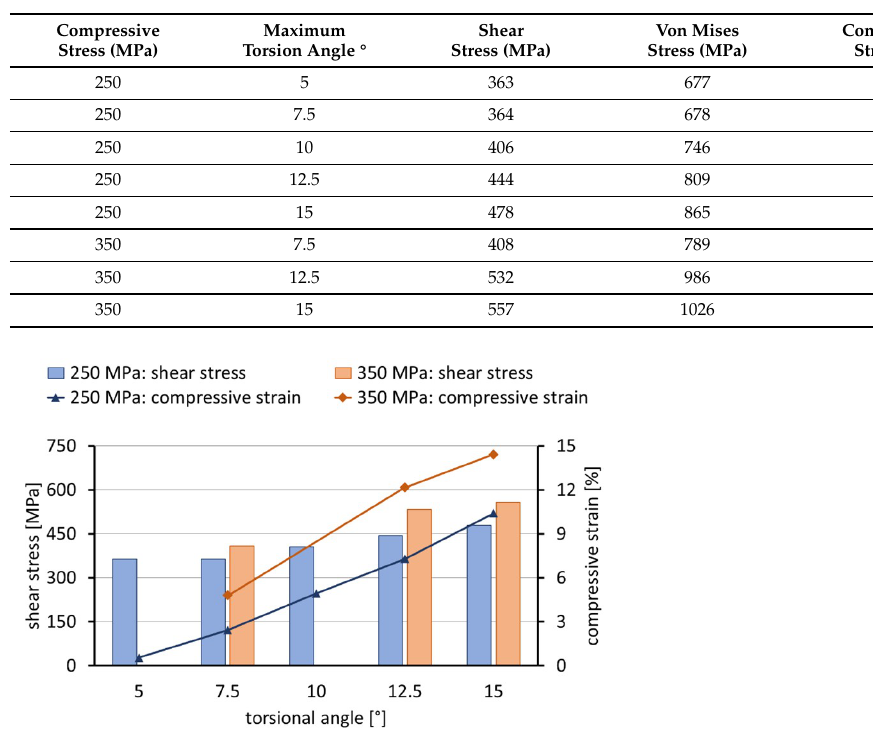
Table 3. Test parameters and resulting maximum shear stress at beginning of experiment and max. compressive strain at the end of each experiment.